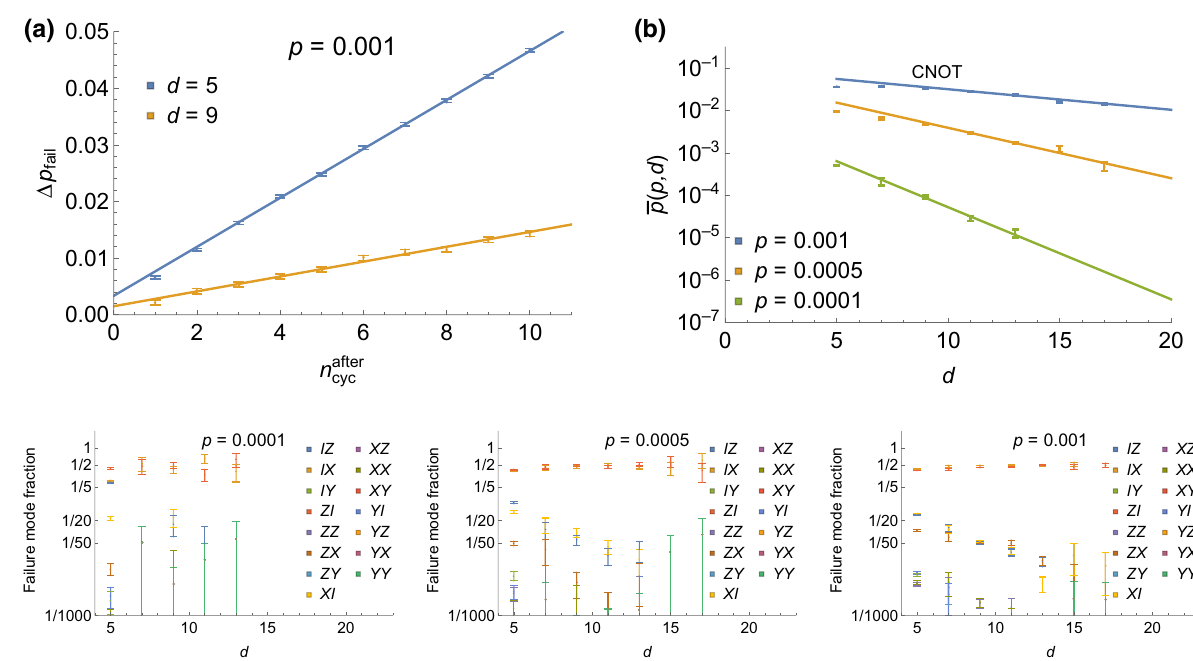
FIG. 18. Analysis of the logical CNOT operation. (a) The change in failure probability between the time immediately after the QEC cycles later. We observe that QEC equilibration occurs after two QEC cycles. (b) transversal application of CNOT gates and n after cyc ( p , d ) in Table I. (Bottom panels) The fraction of For each value of p , we use the ansatz in Eq. (7) to extract the parameters for p CNOT overall failures corresponding to different logical Pauli errors. The dominant errors are ZI and IX , since the logical CNOT propagates X errors onto the second patch and Z errors onto the first patch. Other noticeable errors include IZ and XI , which correspond to the failure over two QEC cycles, but become negligible for large d . The points whose data range falls below the horizontal axis correspond to no observed failures.